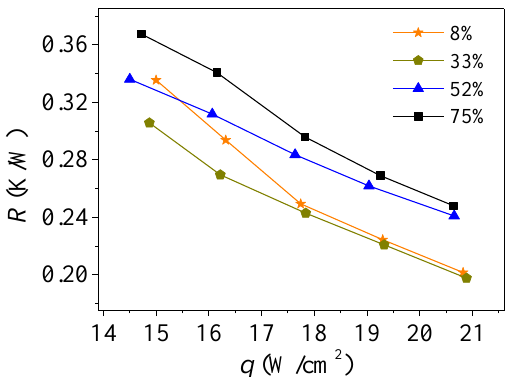
Figure 5. Effect of filling rate on total thermal resistance ( H = 20 mm).